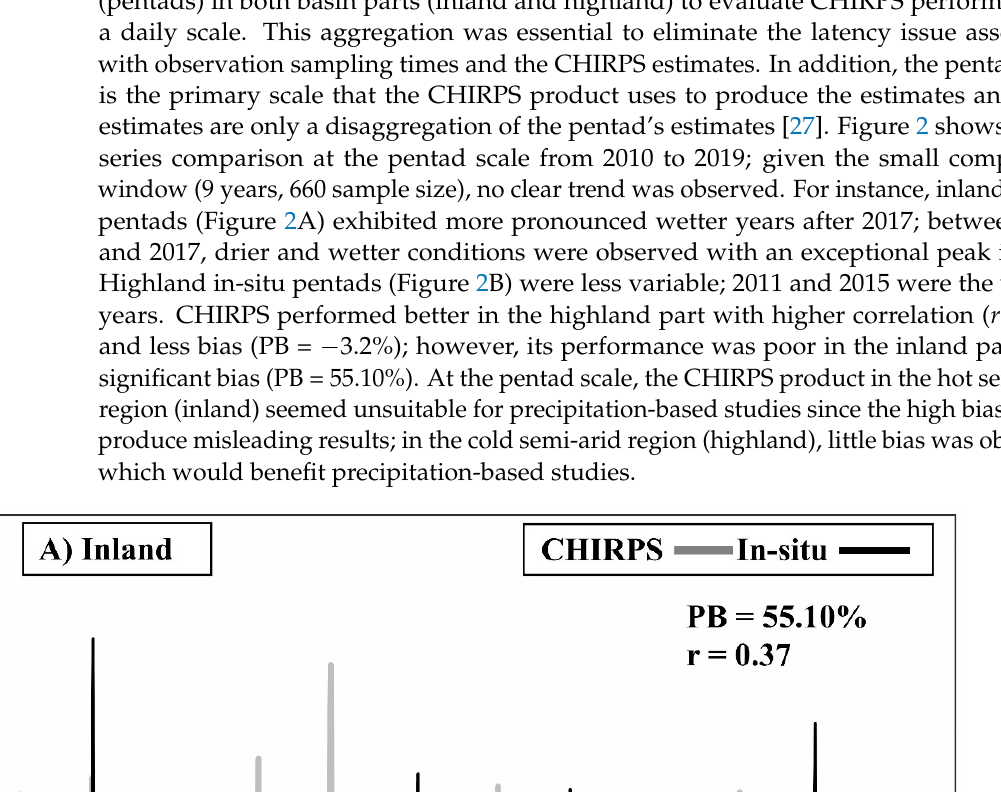
Figure 2. Pentad time series comparison between CHIRPS product precipitation estimates and in- situ precipitation measurements between 2010 and2019, at A ) inland part and B ) highland part. 4.1.2. Daily Detection Skill Detection skill was evaluated for each gauge using the daily accumulation from all rain gauges. Table 4 shows the categorical statistics results for all gauges. PC values rep- resent the overall detection skill within the whole hydrological year, including the rainy (October to March) and dry (April-September) seasons due to the inclusion of the correct detection of zero days. As the region is located in a semi-arid (steppe) climate, most of the year is rainless, and a large percentage of zero precipitation could be expected. Accord- ingly, be tt er values could be expected with this statistic compared to the other categorical statistics. Based on the PC values in Table 4, the overall detection skill of CHIRPS was high. On average, 80% of all CHIRPS estimates were correct. No e ff ect of topography was observed; all gauges in the highlands and inland exhibited close results. Based on the BIAS (FB) results, CHIRPS tended to underestimate rain events (the frequency of rain events) more in the highland part than inland. In the inland part, there was a slight tendency to overestimate/underestimate, where this tendency (under-forecasting) was more pro- nounced in the highland (0.58 on average for the gauges in the highland part). Removing